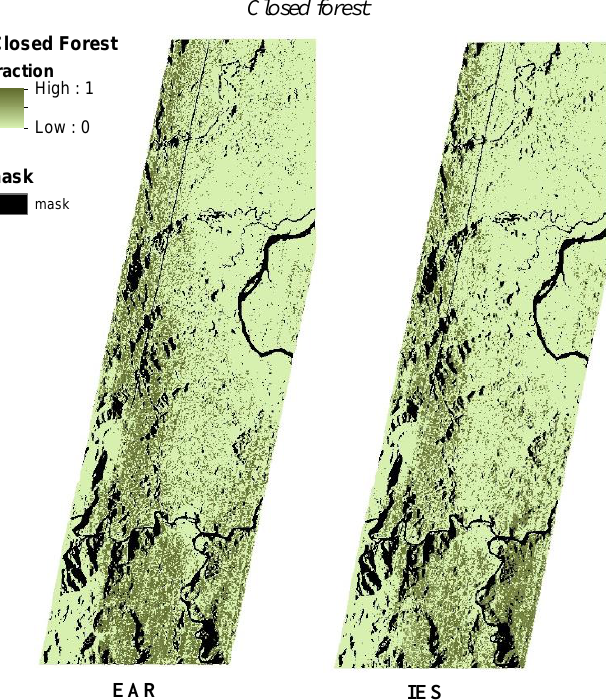
Figure 4. Fractional cover of closed forest based on MESMA unmixing using EAR and IES spectral libraries